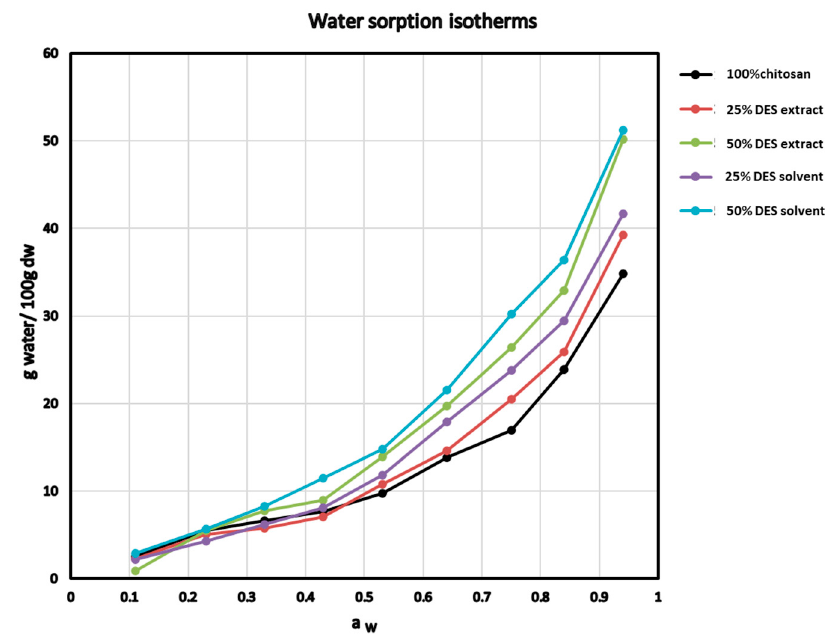
Figure 3. Water adsorption isotherms of chitosan composite films at 25 °C.